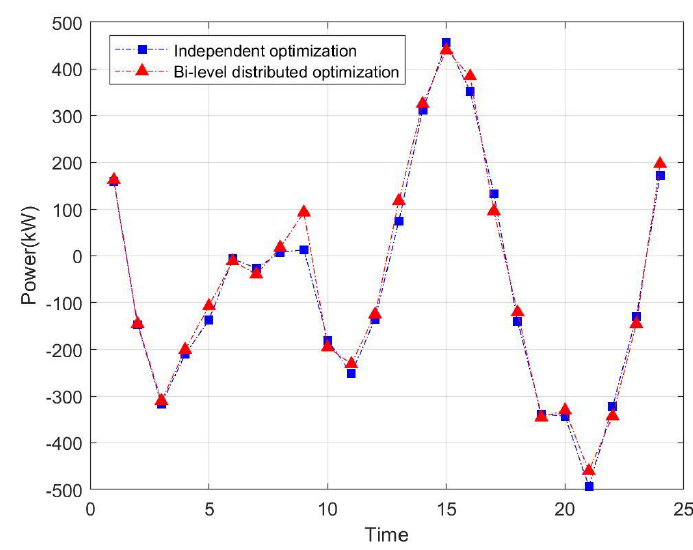
Figure 10. Result of two optimization methods of DSO1.